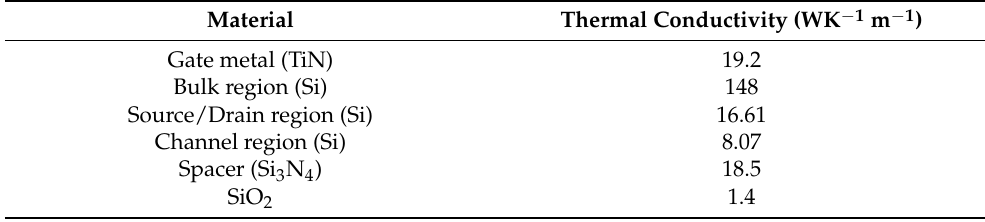
Table 2. Thermal